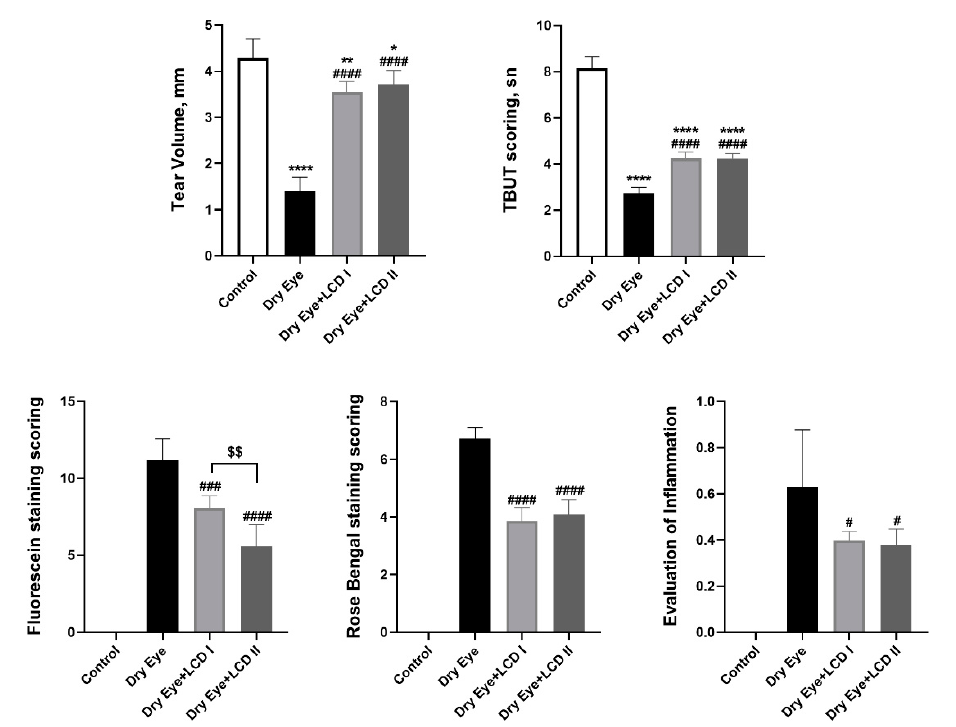
Figure 2. Effect of the combination of lutein/zeaxanthin, curcumin, and vitamin D (LCD) on tear volume, tear breakup time (TBUT) scoring, Fluorescein staining scoring, Rose Bengal staining scoring and evaluation of inflammation in benzalkonium chloride (BAC)-induced dry eye syndrome in rats ( n = 7 per group). Control: No treatment; Dry Eye: BAC-induced dry eye syndrome; LCD I; Dry Eye + LCD I: BAC-induced dry eye syndrome plus LCD I (100 mg/kg body weight); Dry Eye + LCD II: BAC-induced dry eye syndrome plus LCD II (200 mg/kg body weight). Data are presented as a bar with means and standard deviations. (ANOVA and Tukey ′ s post-hoc test. Statistical significance between groups is shown by: * p < 0.05; ** p < 0.01; **** p < 0.0001 compared as control group; # p < 0.01; ### p < 0.001; #### p < 0.0001 compared as Dry Eye group; $$ p < 0.01 compared as Dry Eye + LCD I group).